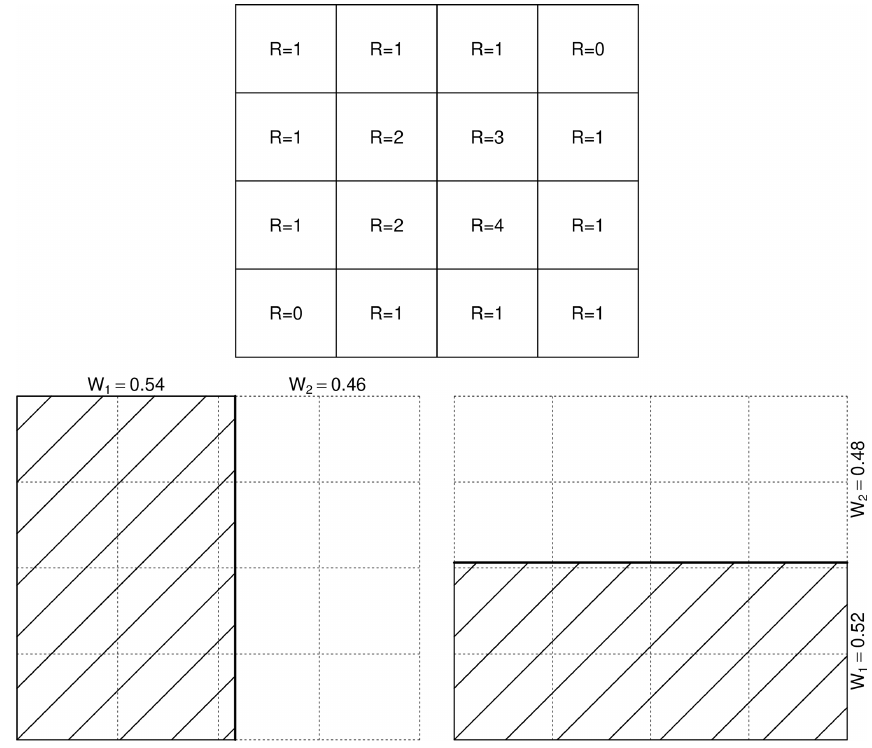
Figure 5. Empirical breakdown coefficients for a 4 × 4 grid cell within the EVA framework (both for vertical and horizontal splits). The empirical weights W 1 and W 2 , which split the rainfall volume in half, are determined by linear